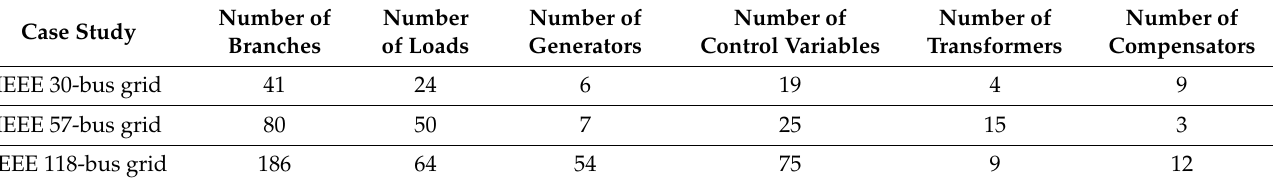
Table 1. Information from the studied